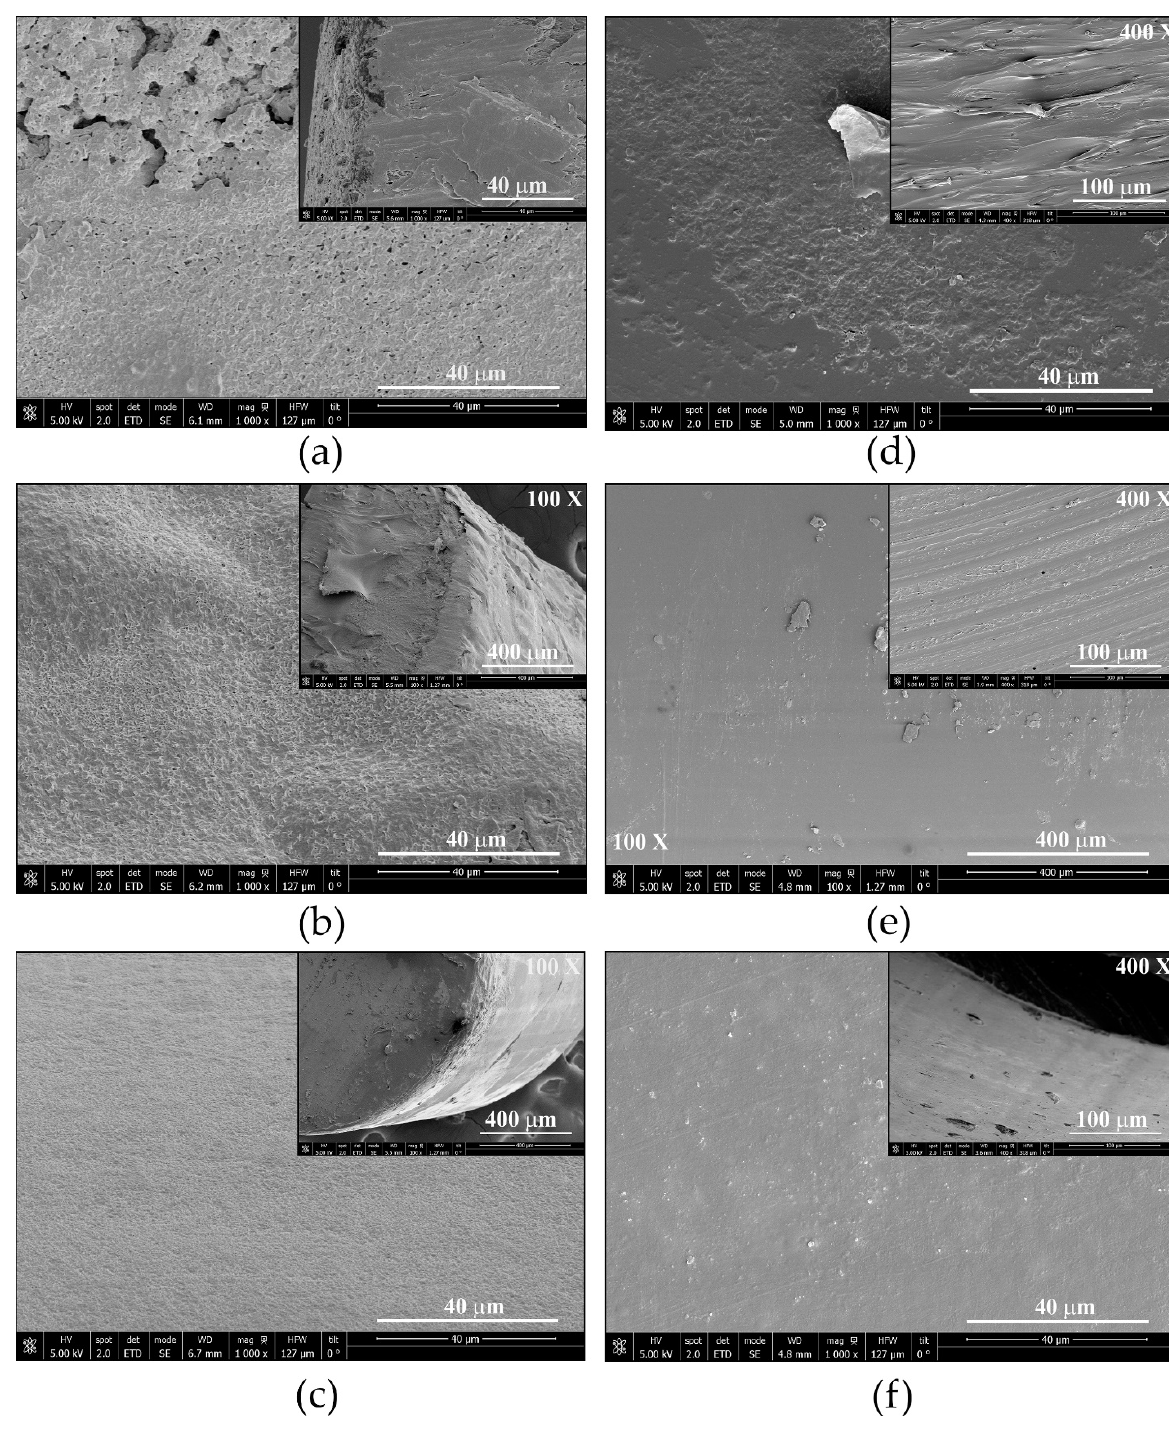
Figure 7. SEM images of longitudinal section of filaments impregnated with ethanolic OLE. ( a – c ) PLA and ( d – f ) TPU after supercritical treatment at 55 °C and ( a , d ) 100 bar; ( b , e ) 250 bar; ( c , f ) 400 bar. The upper right corner images are transversal sections of the polymer filaments. (Magnification × 1000 unless another value is indicated).